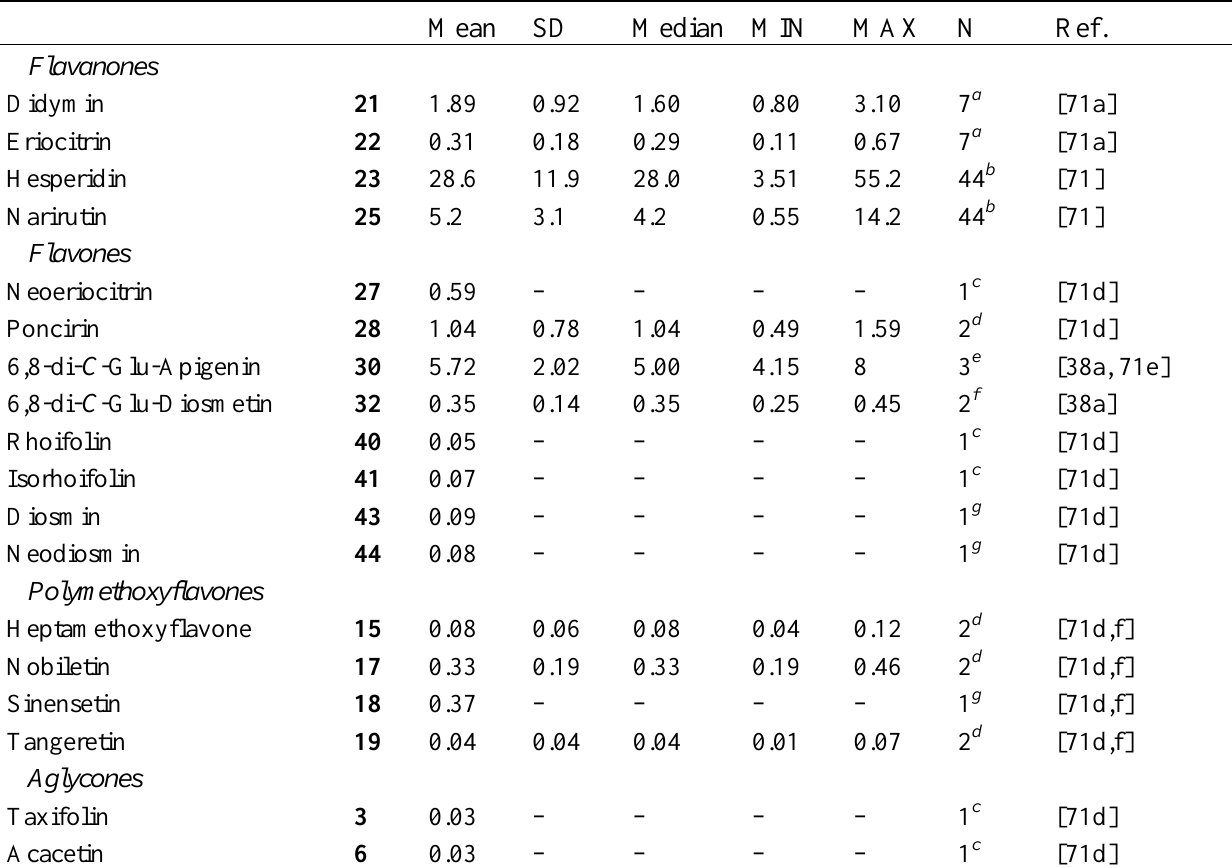
Table 6 . Flavonoid composition of C. sinensis juice (expressed in mg/100